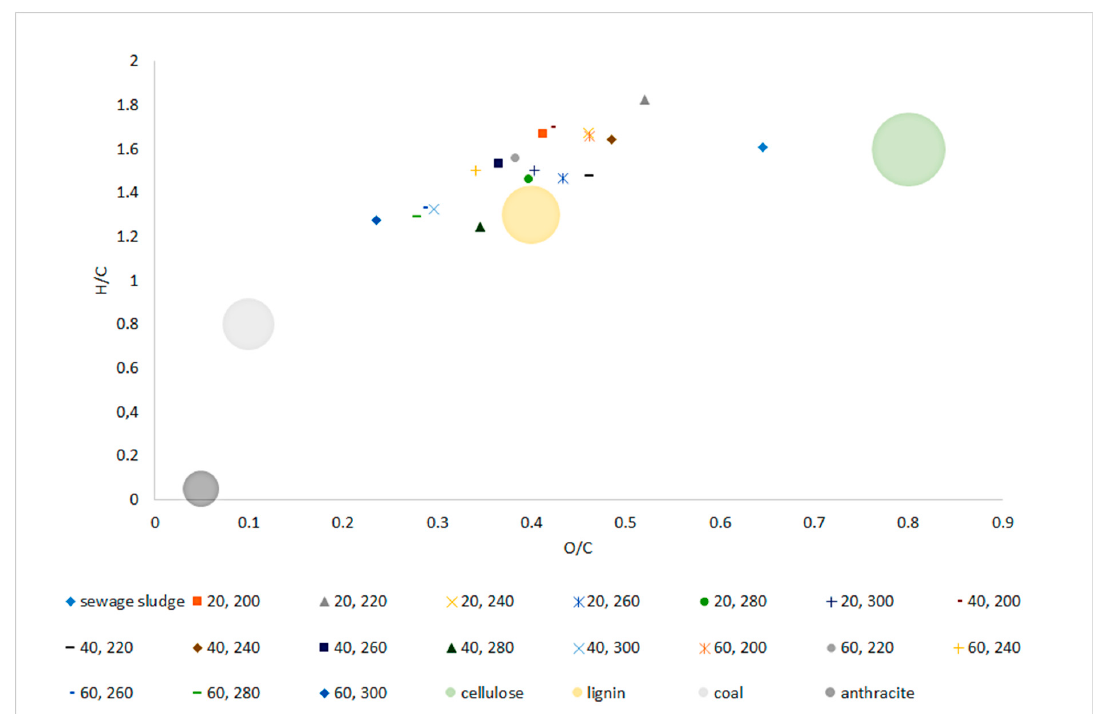
Figure 4. Van Krevelen diagram of dry sludge and torrefied sewage sludge generated at three retention times (20, 40, 60 min), in six temperature variants (200, 220, 240, 260, 280, 300 °C), in relation to coal (anthracite) and biomass (cellulose and lignin) reference.